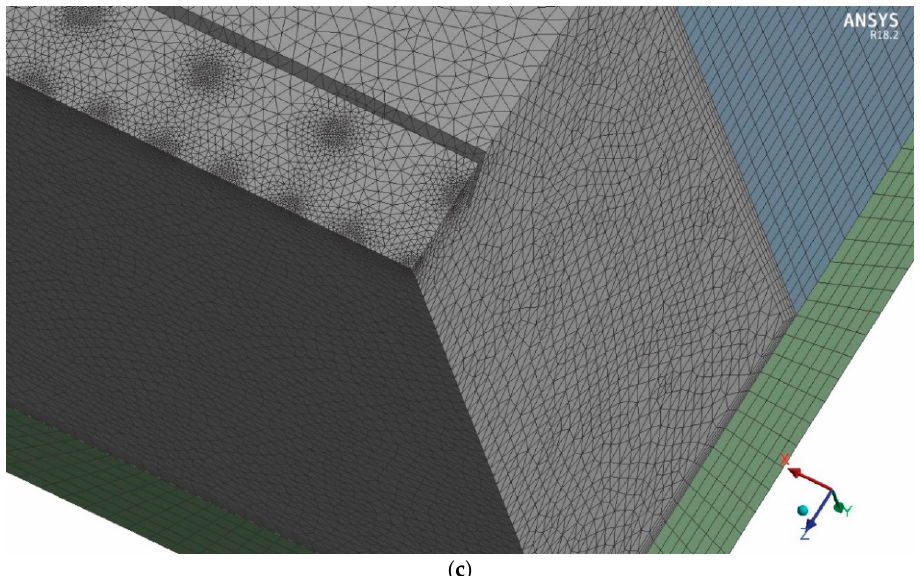
Figure 11. Schematic diagram of steel preheating process with gas torch, fluid domain, and steel plate. ( a ) A half model (x-y plane cut view); ( b ) three-dimensional magnified view of the quarter model; ( c ) mesh model of the quarter model.